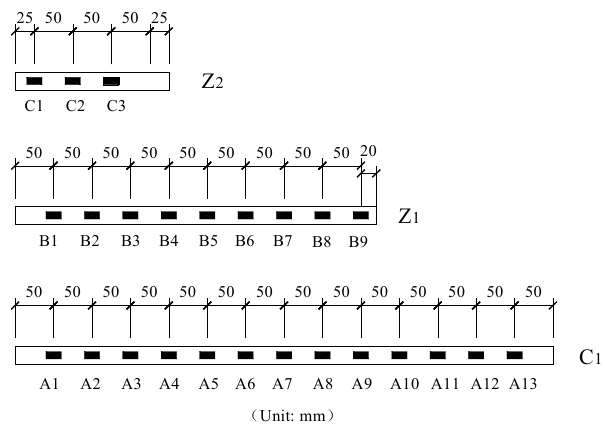
Figure 7. The layout of the strain gauge.